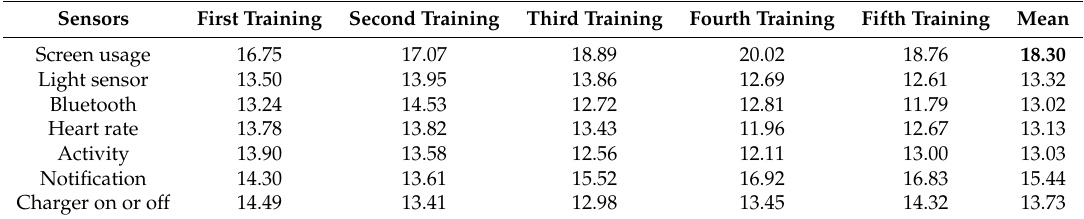
Table 8. Summation of columns of heat maps.